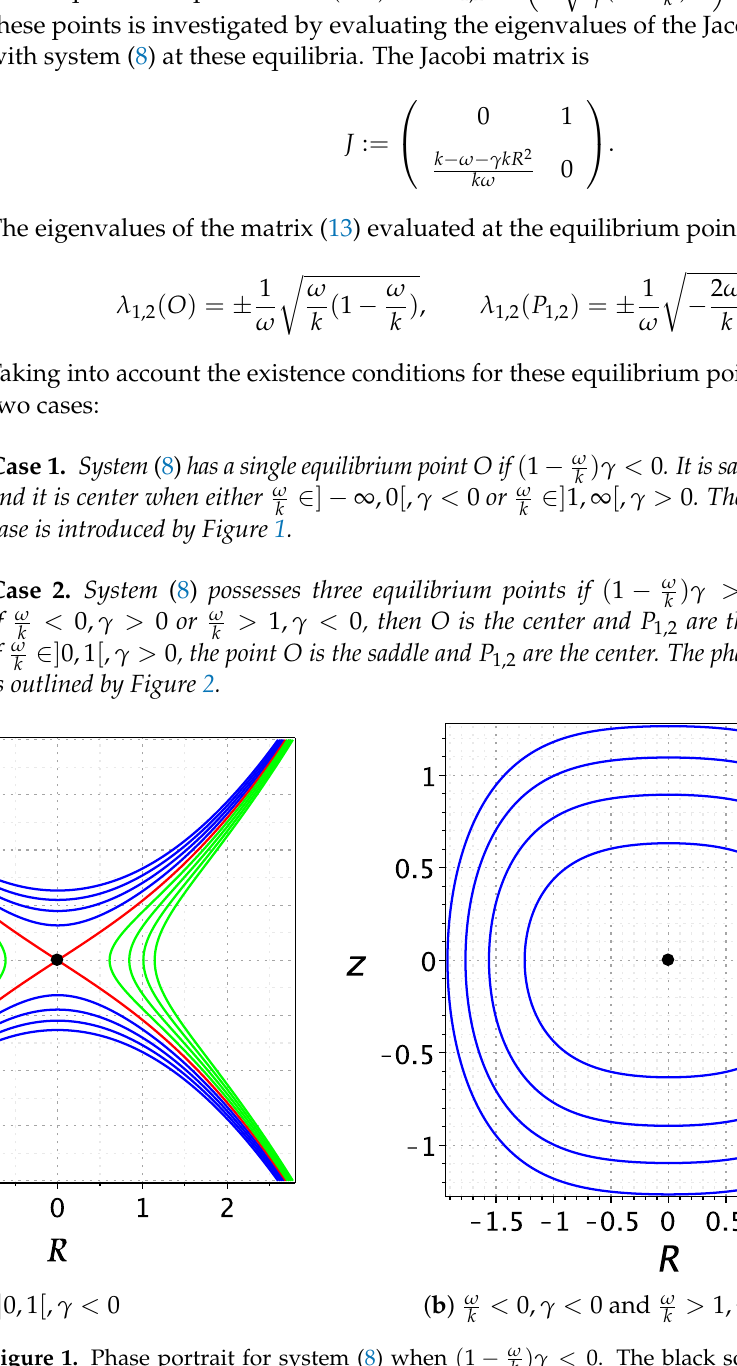
Figure 1. Phase portrait for system (8) when ( 1 − ω equilibrium